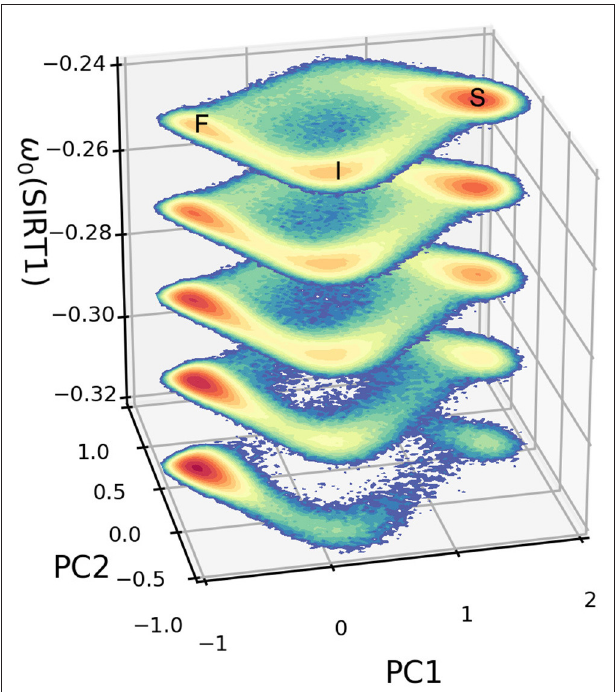
FIGURE 3 | Dynamic landscape of fast-aging and slow-aging upon changes in the basal expression level of SIRT1. The horizontal coordinates represent the top two principal components of gene expression, while the vertical axis represents changes in the basal level of expression for gene SIRT1.